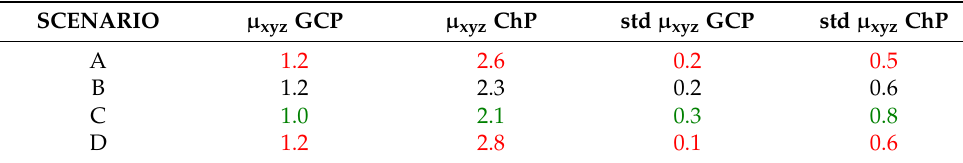
Table 7. Mean µ xyz and std µ xyz of the GCPs and ChPs for the four scenarios. The best results are presented in green and the worst in